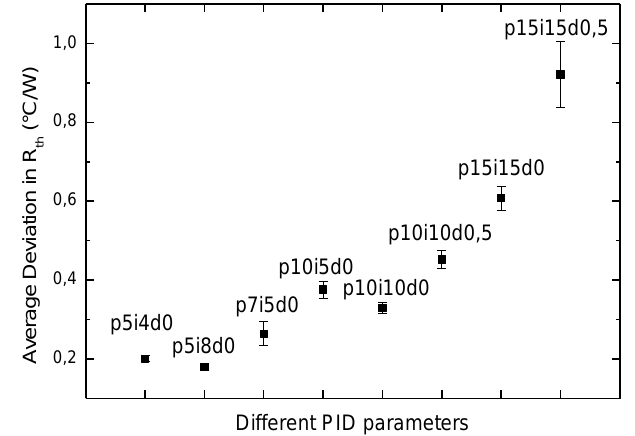
Figure 3. Ten different PID-parameters were examined in a wide regime of configurations at a stable temperature of 37.00 ± 0.02 °C. The average uncertainty in R resistance) is plotted versus the different PID parameters.